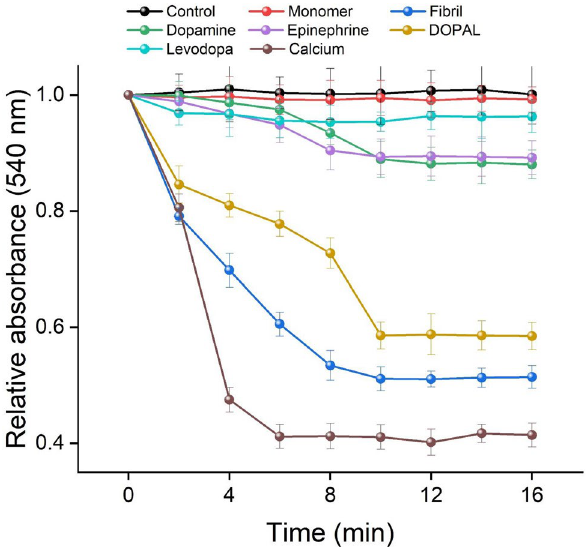
Figure 10. The effect of catechols on the swelling kinetics of brain mitochondria induced by α-syn aggregates. Mitochondrial suspensions (1 mg/mL) were incubated alone or with 5 µM α-syn aggregates, produced in the absence or presence of 200 µM catechols. Untreated mitochondria (control) and those treated with 5 μM α-syn monomer or 2 mM calcium are also indicated. Data are expressed as mean ± SD with n =